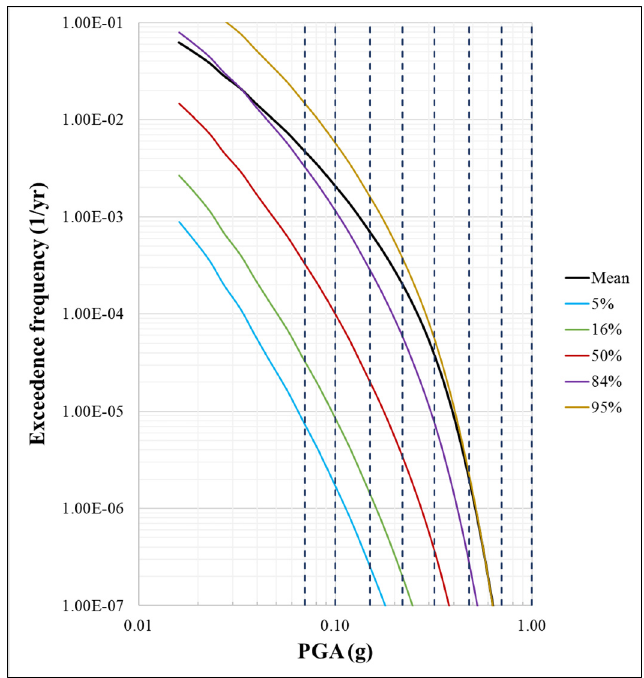
Figure 2. Seismic hazard curve.